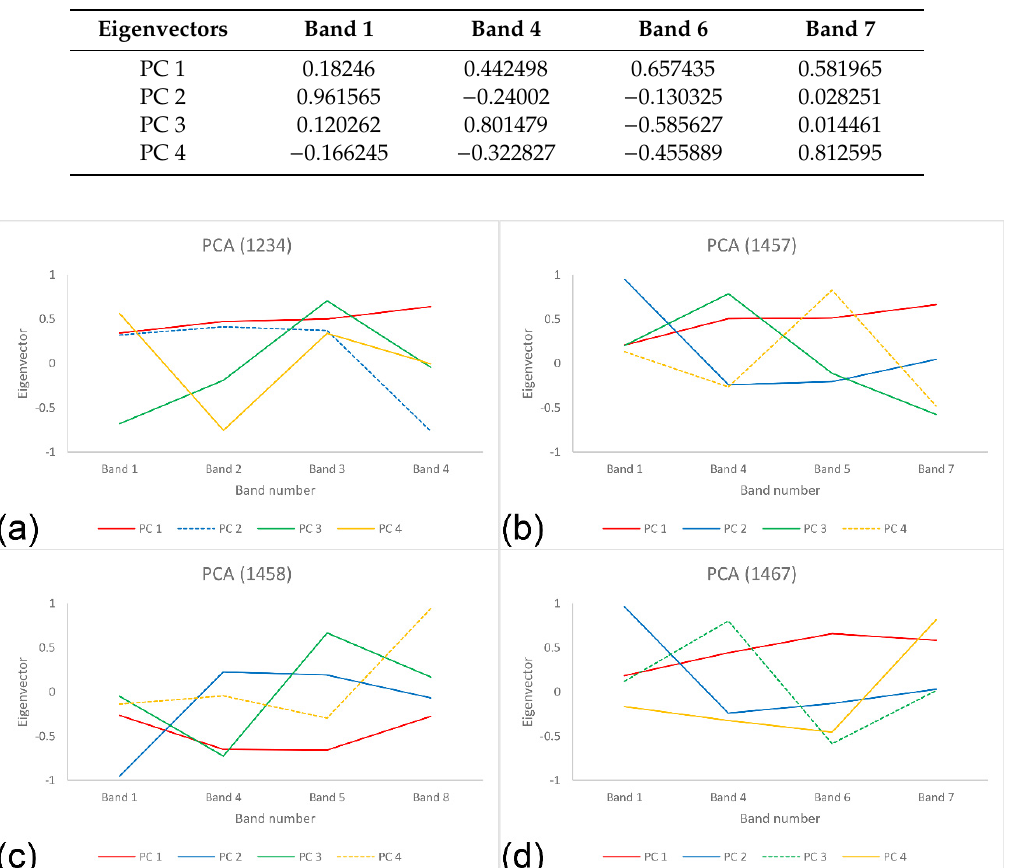
Table 4. Eigenvectors of the principal component analysis on a spectral subset of the ASTER data for detecting the phyllic alteration zones in the study area.